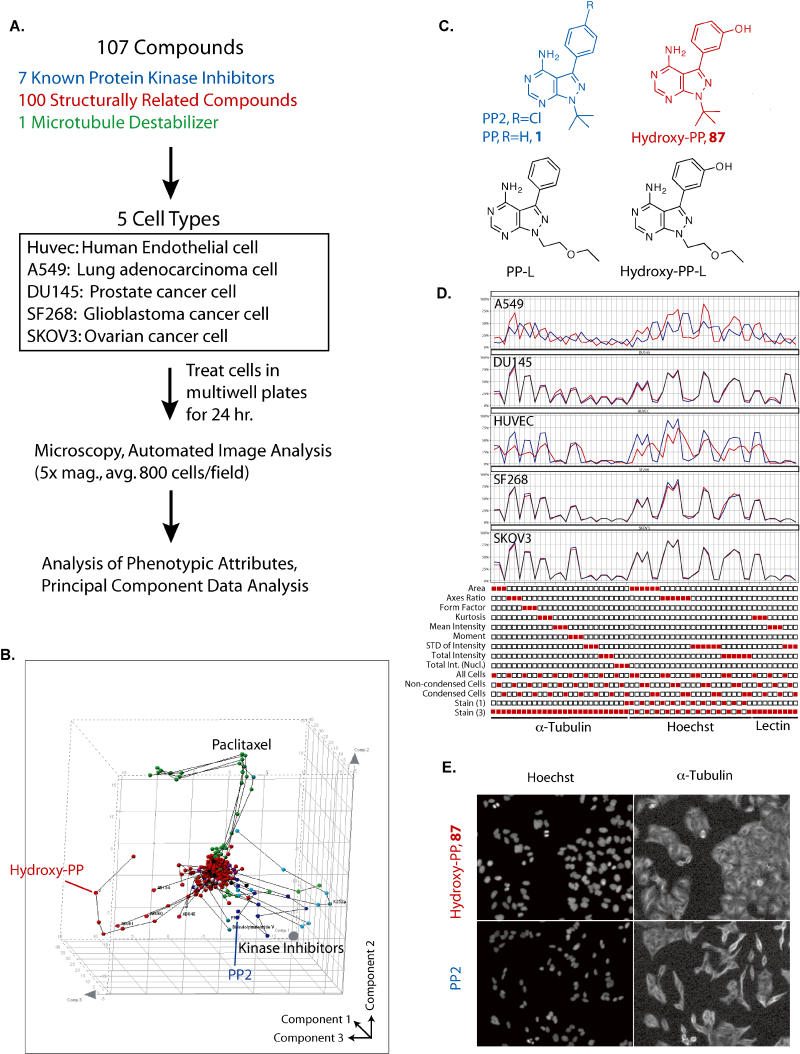
Cell Morphology–Based Screen for Biologically Active Small Molecules(A) Steps in the drug-screening process. Five human cell types, including one primary and four cancer cell lines, were treated for 24 h with the screening library that included compounds of known function and related analogs. The Cytometrix (TM) data analysis package was used to analyze microscopy data for each treatment condition.(B) PCA plot of the phenotypic attributes. Colored spheres represent a single compound at one concentration (ranging from 6 nM to 40 μM by 3-fold increases); lines connecting the spheres indicate a single compound's effects over a range of concentrations. Spheres are colored as follows: known protein kinase inhibitors (blue), paclitaxil (green), and novel compounds structurally related to the protein kinase inhibitors (red). The PCA provides aggregate variables termed “components” made up of multiple independent variables, each with a “loading factor.” These values are provided in Table S2. Structures of each compound are given in Figure S1.(C) Structures of the known kinase inhibitors PP and PP2 (blue), as well as the novel “hit compound” hydroxy-PP (red), are shown. Linker analogs of PP (PP-L) and hydroxy-PP (hydroxy-PP-L) that were used to ascertain the functional tolerance of replacing the t-butyl substituent at N-1 of the “hit compound” hydroxy-PP are shown.(D) Morphological attribute tabulation for cells treated with 129.4 μM PP2 (blue lines) or 0.4 μM hydroxy-PP (red lines) in each of five cell types. Data for the x-axis is grouped by the probe used (α-tubulin antibody, Hoechst dye, and lectin stain). Each of 14 attributes contributing to the magnitude of the response (y-axis) is shown as a red-filled square.(E) Visual morphology of A549 cells treated with hydroxy-PP or PP2. Hoechst dye or α-tubulin antibody was used to stain cells. The PP2-treated cells are more elongated and have more a condensed nuclear structure as compared with hydroxy-PP-treated cells.